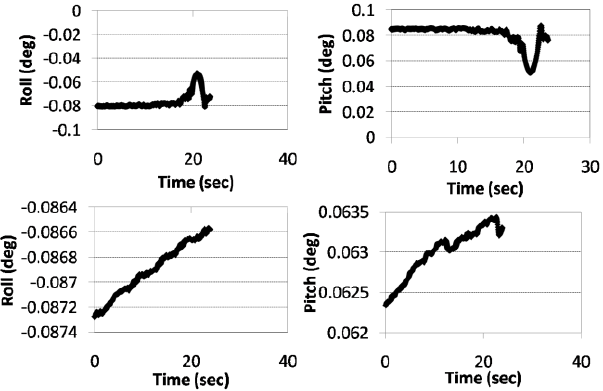
Figure 3 Rolland Pitch profiles of Orbit 4874 (above) and orbit 2785 (below)